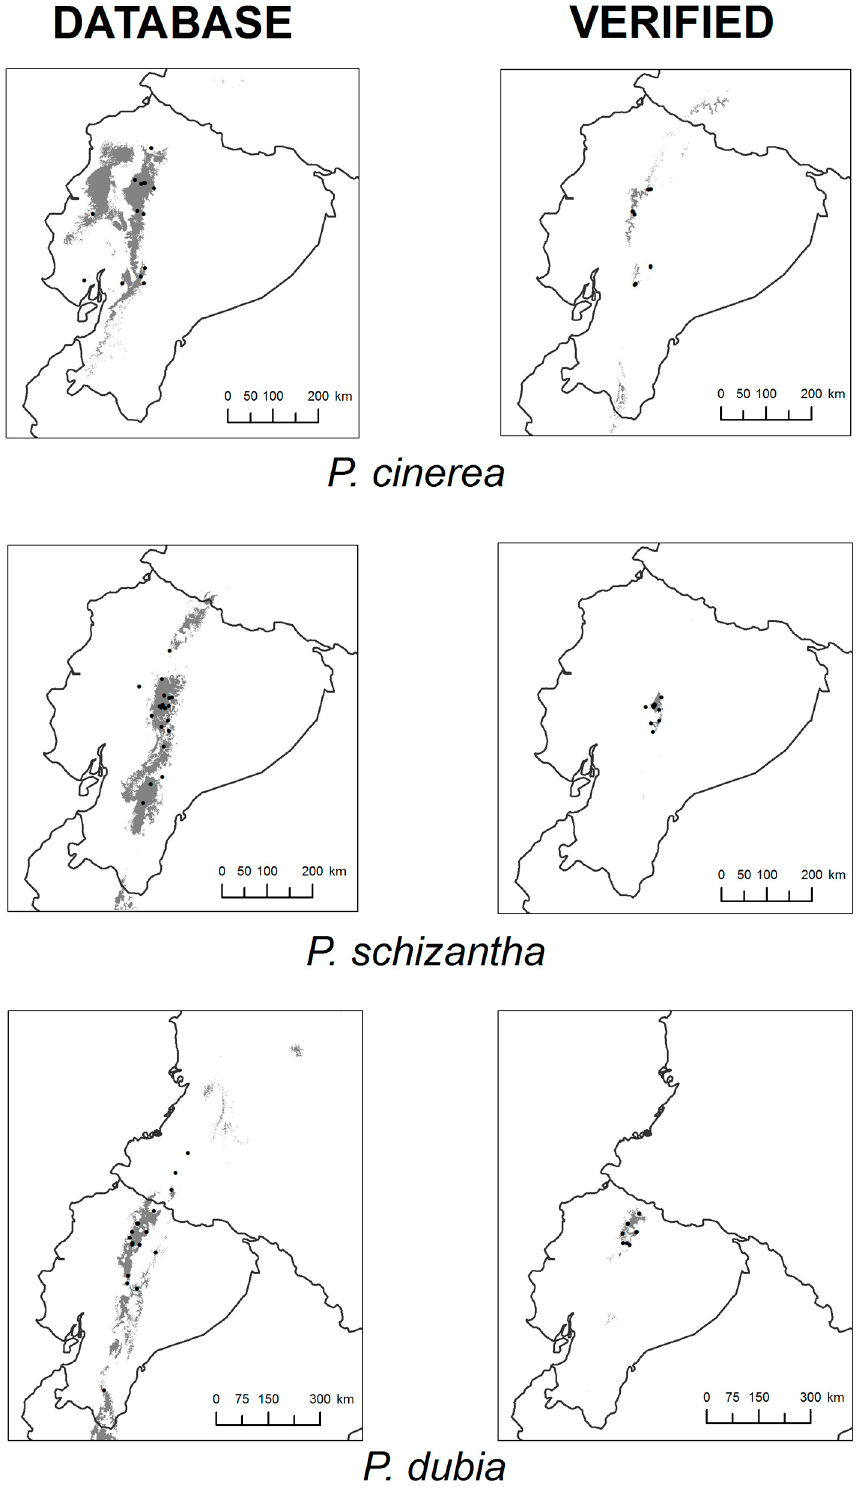
Figure 1. Distribution maps for Phaedranassa cinerea , P. schizantha and P. dubia (Amaryllidaceae) in Ecuador. Darker areas indicate predicted potential ranges based on online database records ( left ) and verified records ( right ). Points show the actual species distribution.